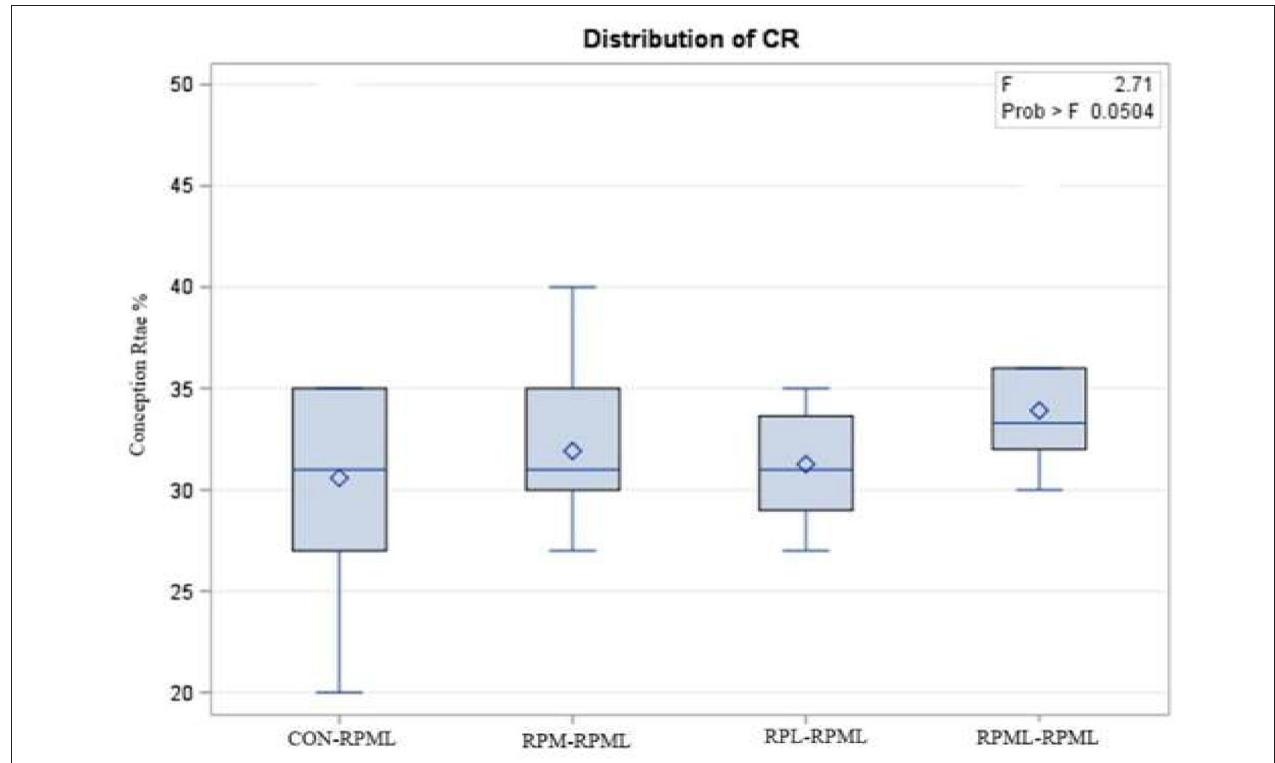
FIGURE 12 | Effect of supply ruminally protected Met and Lys to transition and milking dairy cows on conception rate. Values are means; standard errors are represented by vertical bars.